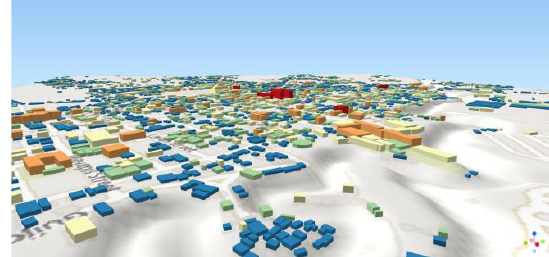
Figure 8. Panoramic view of the LOD1 3D City Model generated using mean heights.